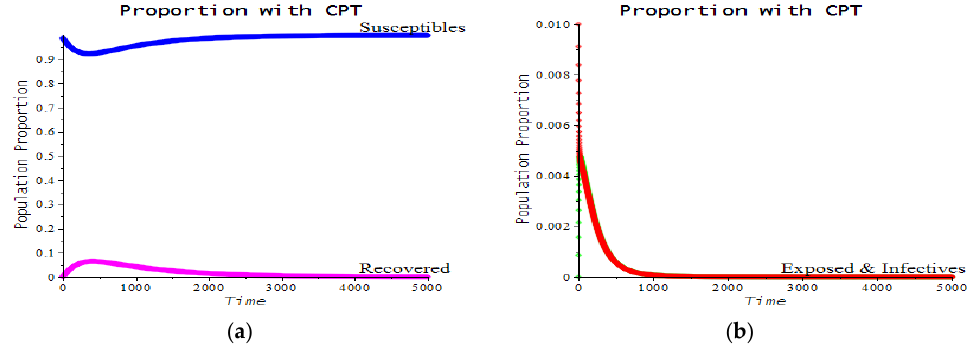
Figure 3. A graph of the SEIR model with CPT, showing the susceptible and recovered classes ( a )